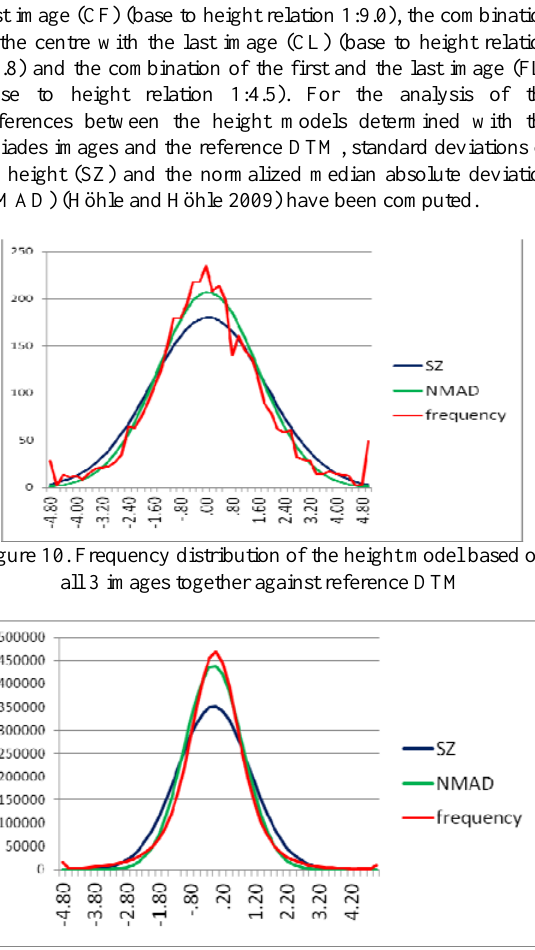
Figure 11. Frequency distribution FL -